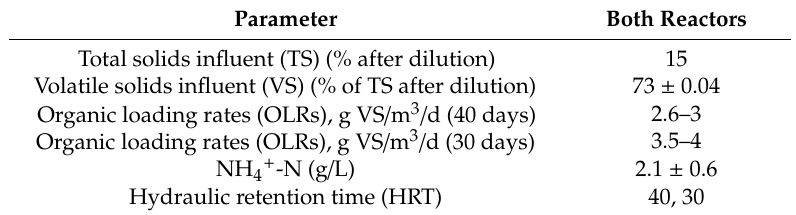
Table 1. Feed characteristics and operating parameters; average values of input